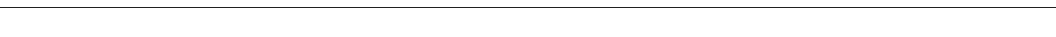
Fig. 8 Varying miRNA pro fi les across cell lines affect reporter expression. a – c The median-transformed reporter RNA levels for perfect match MREs (see also Supplementary Figure 9) as a function of the miRNA expression levels, as quanti fi ed by published microarray for K562 34 , MCF7 45 , and HepG2 46 , for the ten selected miRNAs. Calculated R 2 and associated p -values are indicated. For MCF7 and HepG2, hsa-miR-223 was excluded from this analysis due to its extremely low expression. d Pairwise comparison of transformed reporter RNA levels for perfect match MREs (see also Supplementary Figure 9) for the ten selected miRNAs. Hsa-miR-21 is annotated in every subplot. e Pairwise comparison of transformed RNA levels for all measured reporter library variants. The colored points indicate different MRE types for hsa-miR-21 as shown in the legend. f Transformed RNA levels of reporter constructs with different MRE types for hsa-miR-21 in different cell lines. Controls contain control sequences instead of the MRE. The "None" group contains the context with no inserted sequences. Boxplots marked with * are signi fi cantly different ( p < 0.05, Mann – Whitney U one-sided test) from the controls group. See also Supplementary Fig. 10. g Transformed RNA levels as a function of number of MRE sites for K562, MCF7, HepG2, and HEK293 cells. Analysis was performed as in Fig. 4e per cell line. Plots shown are for 3 ′ complementary with control 1 and 8mer with control 1 at the top and bottom rows, respectively. Colors represent results from different cell lines as shown in the legend. A stronger effect is observed for hsa-miR-21 in MCF7 cells, where it has the strongest activity. See also Supplementary Fig.